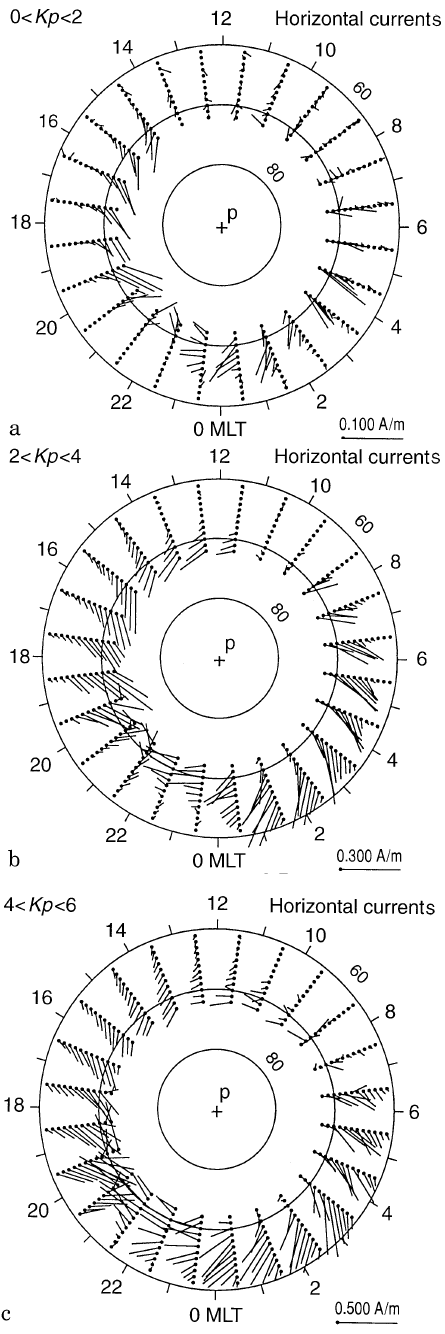
Fig. 2. Polar distributions of the statistical height-integrated hori- zontal currents for the three magnetic-activity ranges (note that the vector scale, indicated at the bottom of each part, increases with magnetic activity)